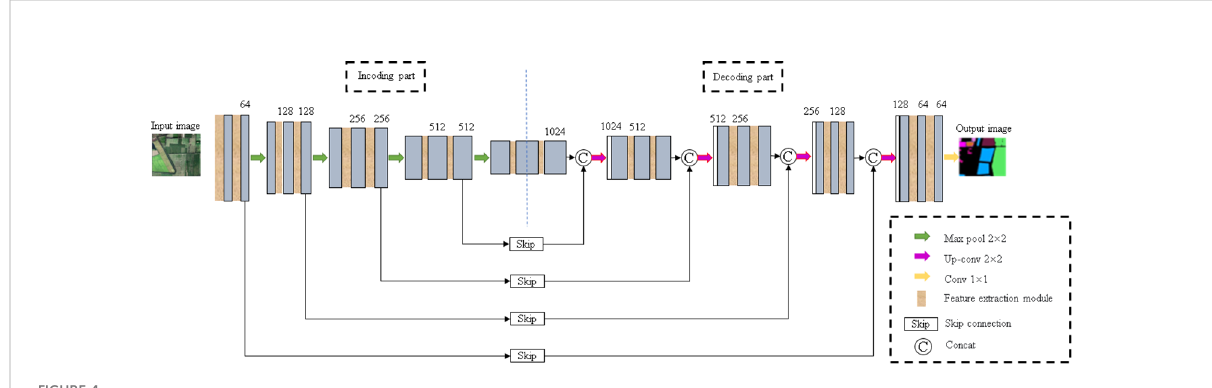
FIGURE 4 Improved U-Net model.